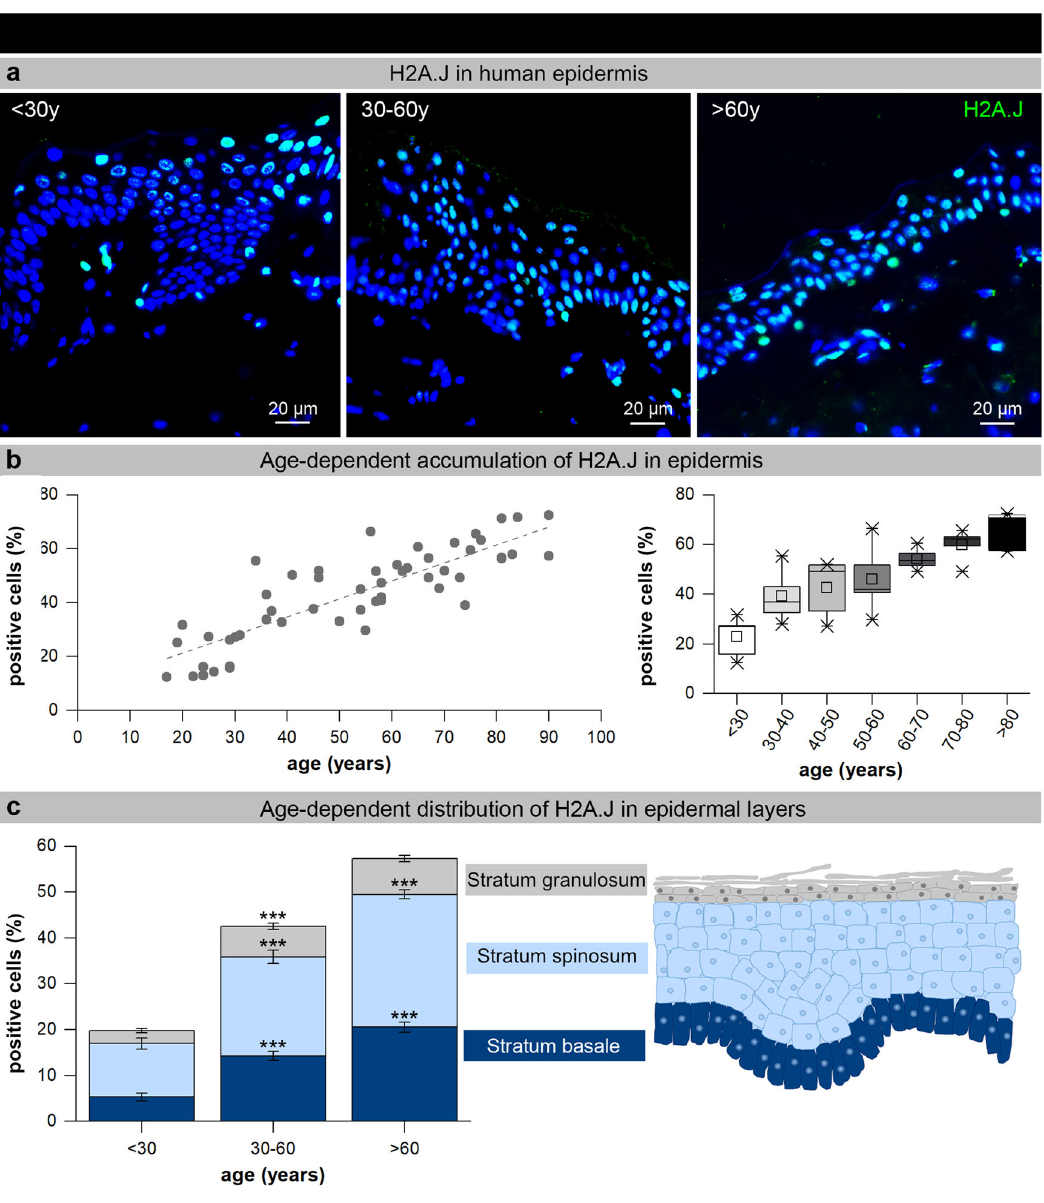
Fig. 1 Age-dependent accumulation of H2A.J in human epidermis. a IF micrographs of H2A.J staining in human epidermis of young (<30 y), middle-aged (30 – 60 y), and aged (>60 y) donors. b Graphic presentation of H2A.J expression (H2A.J + cells in percentages) depicted for the entire age cohort ( n = 53; left panel) and depicted per age-group (right panel: the horizontal line in the box represents the median, the box shows the interquartile range [25th – 75th percentile] and the whiskers represent the 5th – 95th percentile.) c Graphic presentation of H2A.J expression (H2A.J + cells in percentages) in different epidermal layers in relation to donor age. *** p < 0.001 signi fi cant statistical difference to younger